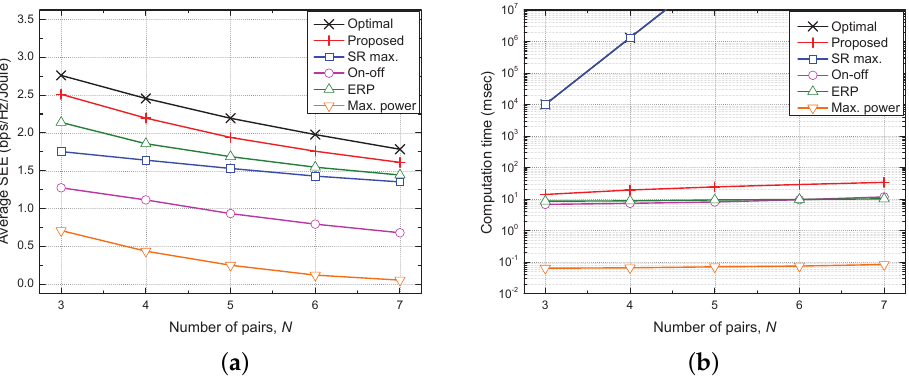
Figure 4. Comparison of performances of five considered schemes as a function of number of SU pairs ( N ). ( a ) Average SEE vs. N . ( b ) Computation time vs. N